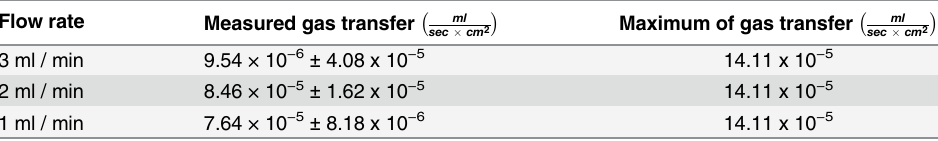
Calculated gas transfer through coated Lumox ™ slides, measured in the redesigned ENDOXY system. Results show a high standard deviation for a blood fl ow of 3 ml / min. At a blood fl ow of 1 ml / min and 2 ml / min, gas transfer through the cell-coated membrane is